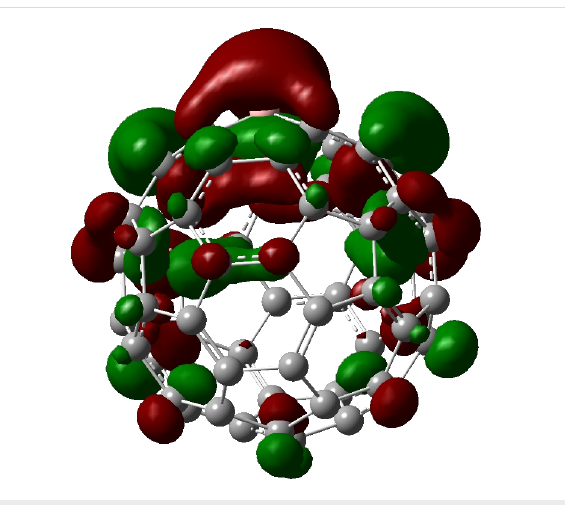
Figure 3: LUMO of neutral BC 59 . The orbitals are drawn at an isosur- face value of 0.02. The colours of the orbitals: red, positive wave func- tion; green, negative wave function. Atom colour code: pink, boron; grey,